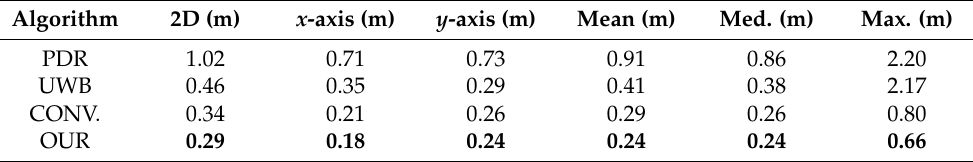
Figure 17. Box plot of positioning errors in multi-lap LOS+NLOS scenario. Table 4. Positioning errors in multi-lap LOS+NLOS